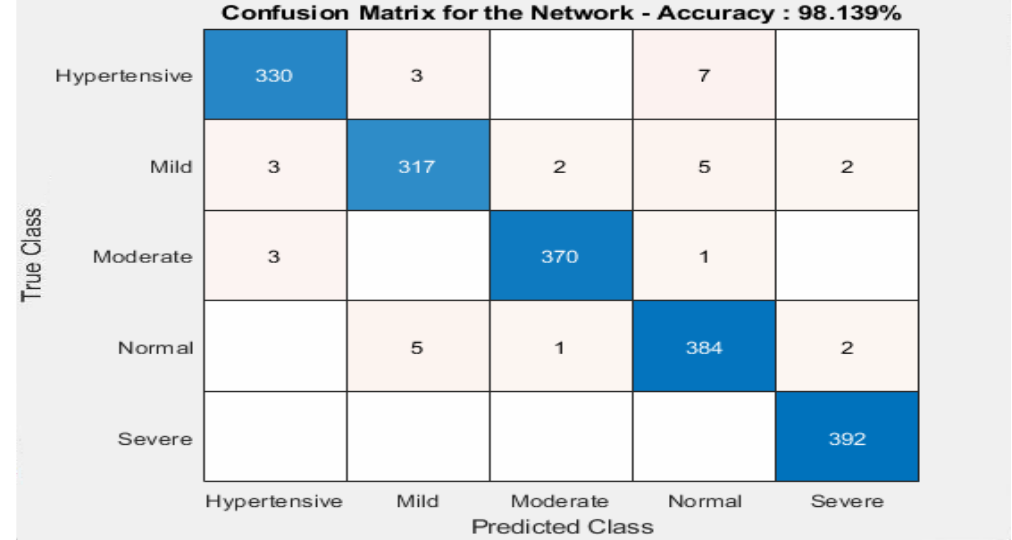
Figure 10. Confusion matrix of MESSIDOR and ODIR datasets.